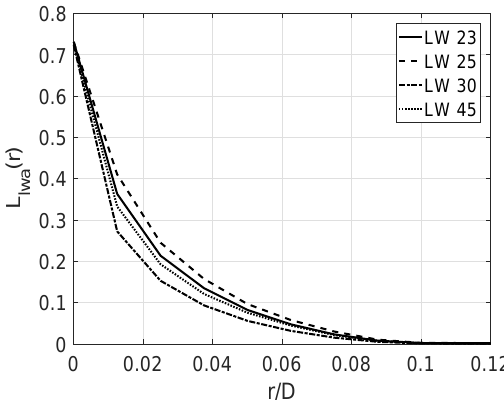
Figure 9. L lwa for the LWC samples (note: the results of r / D range between 0 and 0.12 are only presented